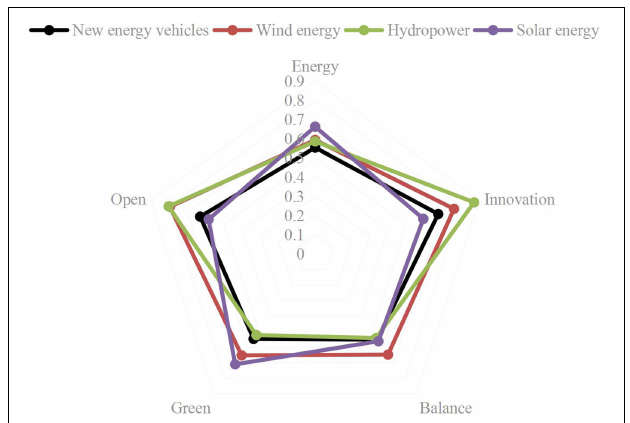
FIGURE 5 | Comprehensive correlation degree of the four new energy industries in different